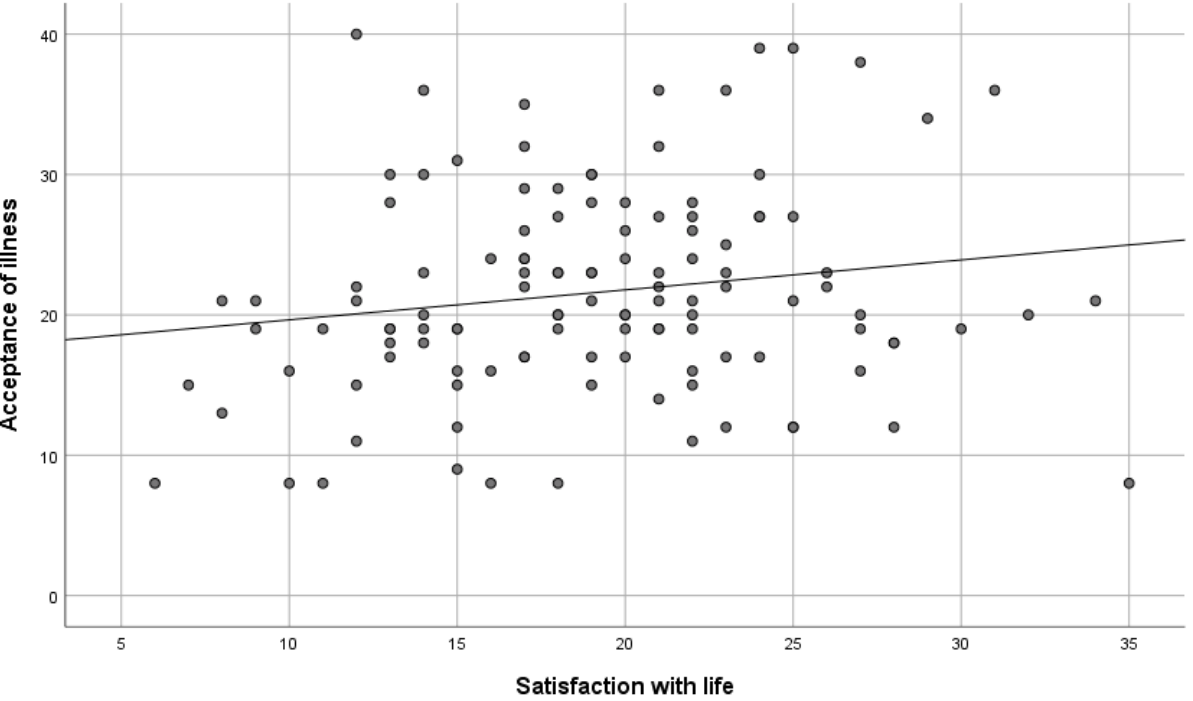
Figure 1. Satisfaction with life versus acceptance of illness.